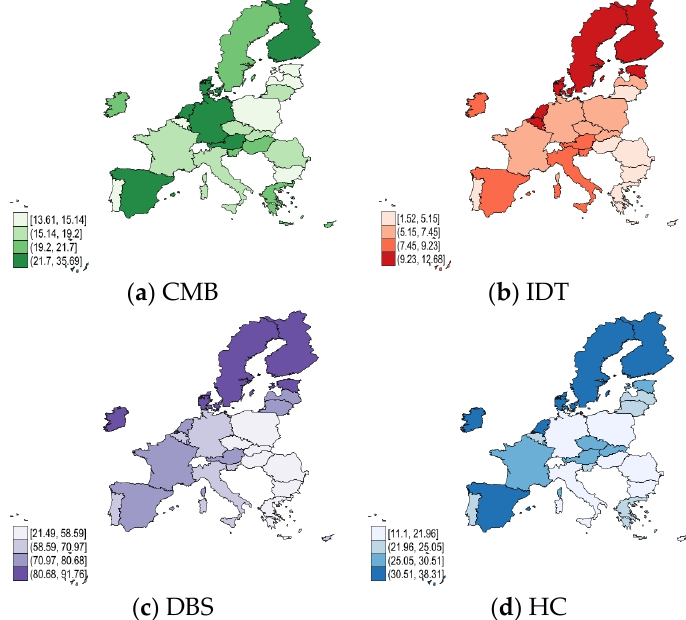
Figure 2. Digitalisation indicators, EU-27, 2021. Source: Authors’ research in Stata17.